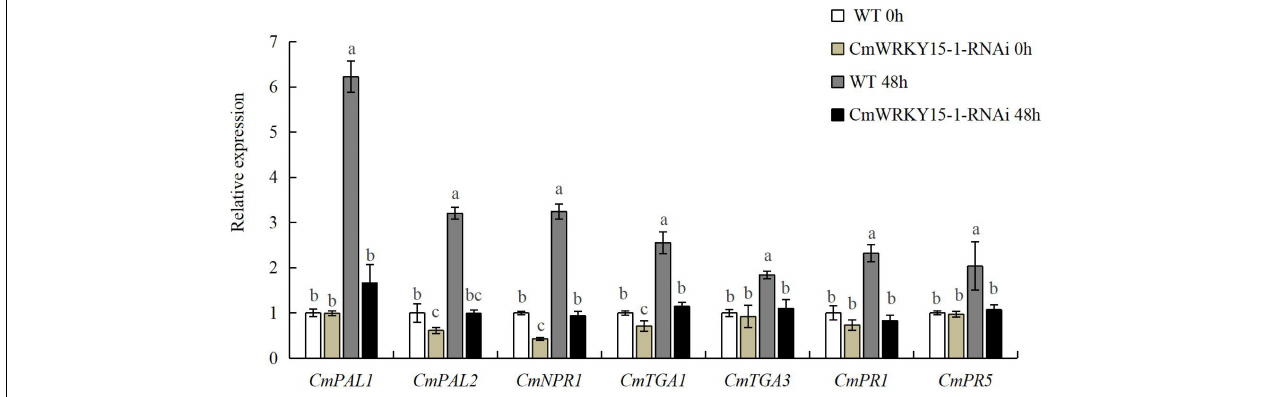
FIGURE 3 | Expression of differentially expressed genes (DEGs) in wild-type (WT) and CmWRKY15-1 -RNA interference (RNAi) lines of ‘C029.’ Error bars show standard deviation of three replicates. Different letters demonstrate significantly different by Duncan’s multiple range test at p <